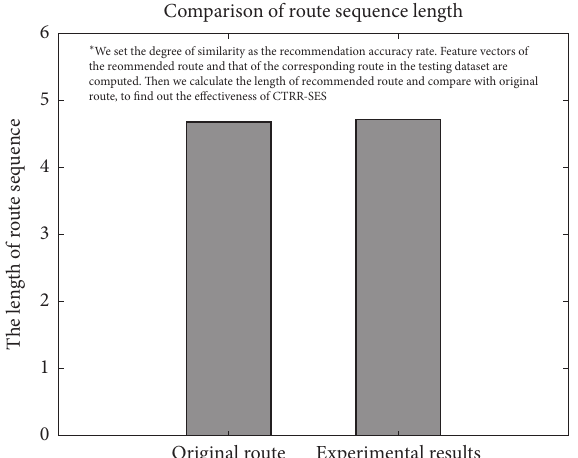
Figure 5: The length comparison of the original route with the recommendation route.